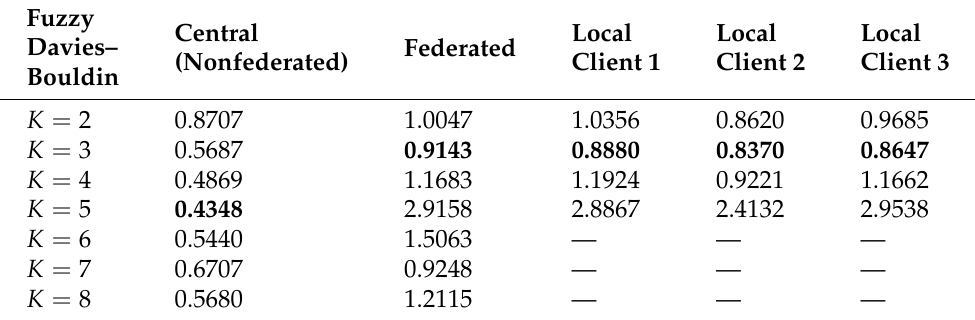
Table 2. Local and federated clustering results on the motivational dataset with federated averaging. The best result per experiment (column) is bold